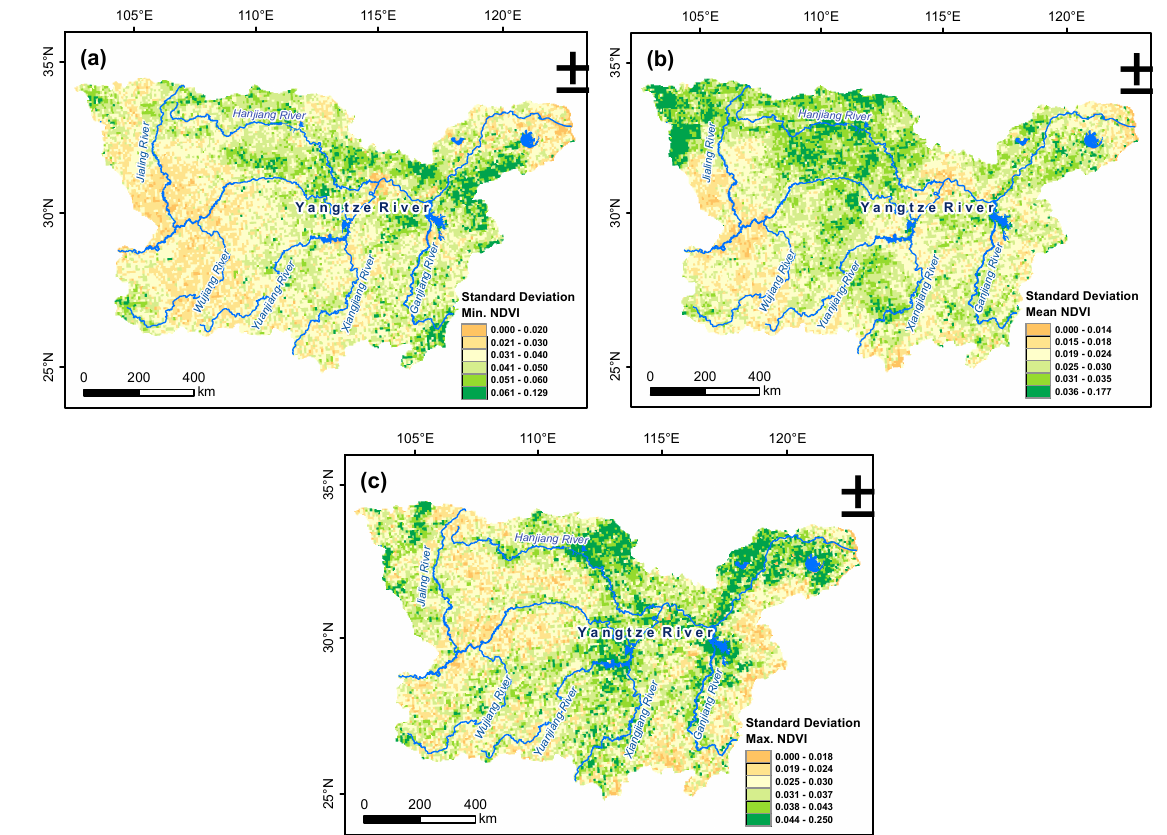
Figure 5. Standard deviation of three NDVI indices in the MLR-YR from 1982 to 2012: ( a ) minimum NDVI, ( b ) mean NDVI and ( c ) maximum NDVI.